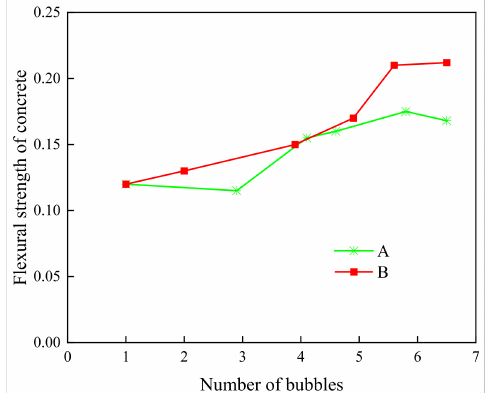
Figure 26. The effect of bubble content on flexural strength. Concrete test blocks with different mix proportions A and B.